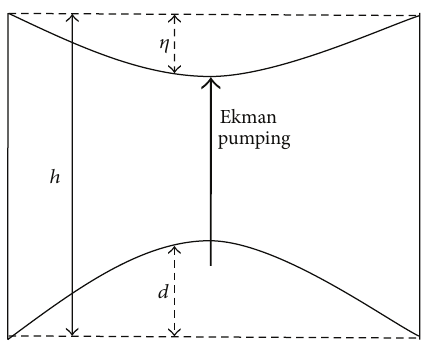
Figure 3: The two-layer reduced gravity